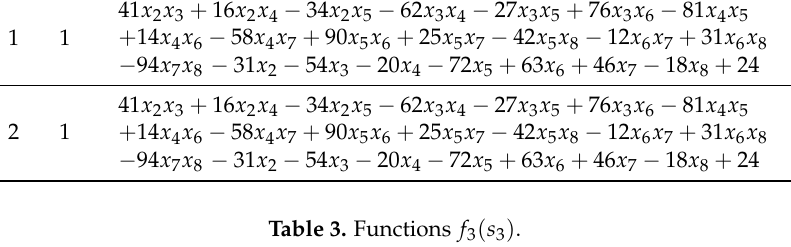
Table 3. Functions f 3 ( s 3 )